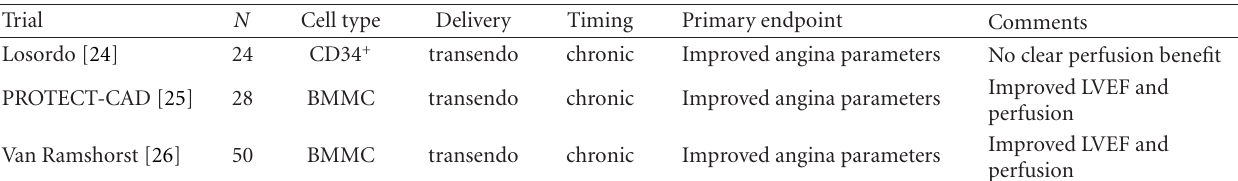
Table 4: Randomized clinical trials in patients with chronic myocardial ischemia.